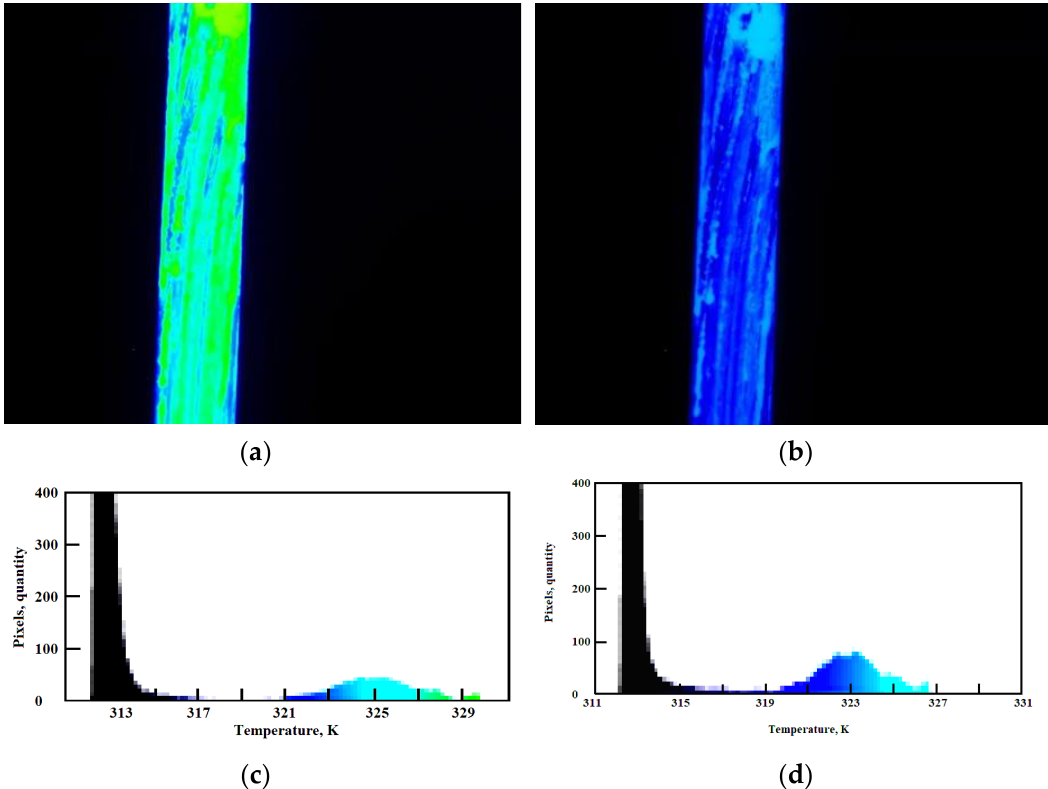
Figure 3. IR thermograms for studying ECE in an amorphous Ti 2 NiCu ribbon. ( a ) The undeformed tape, ( b ) the stretched tape, ( c ) a temperature distribution diagram in the undeformed ribbon, and ( d ) a temperature distribution diagram in the stretched ribbon.